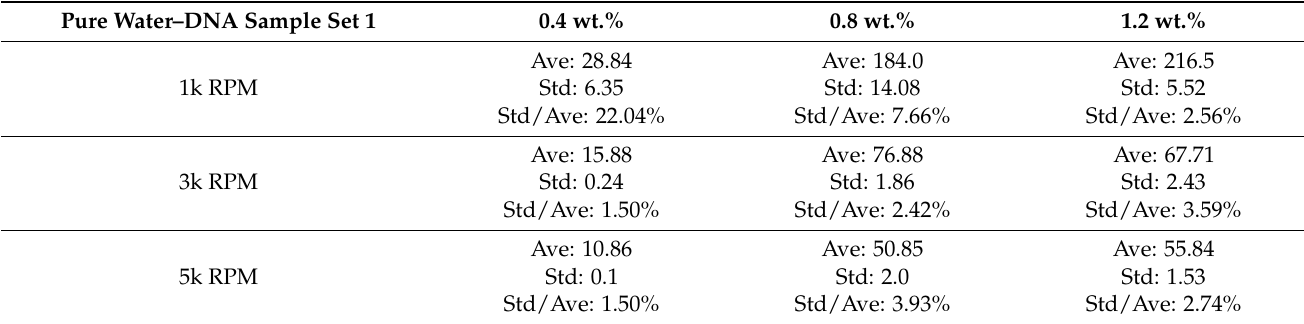
Table 2. Average thickness (nm) and standard deviation (nm) from 5 × 5 measurements of a pure water–DNA sample set 2. Pure Water DNA Sample Set 2